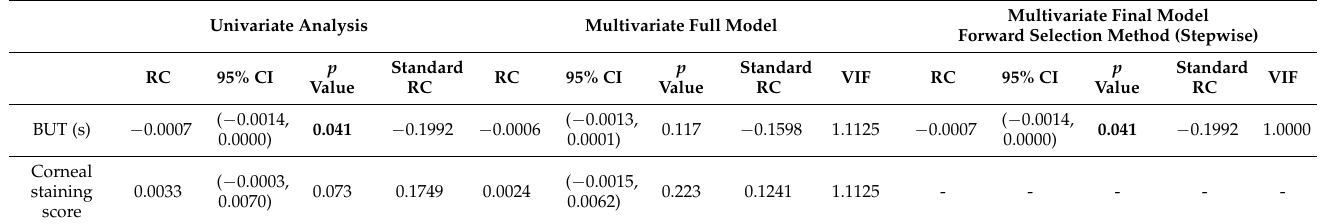
Table 4. Results of multiple regression analysis for evaluating the contributions of BUT and the corneal staining score to the measurement repeatability of axial